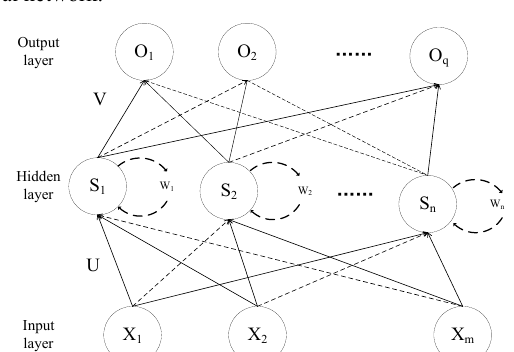
Fig. 1. Recurrent neural network.